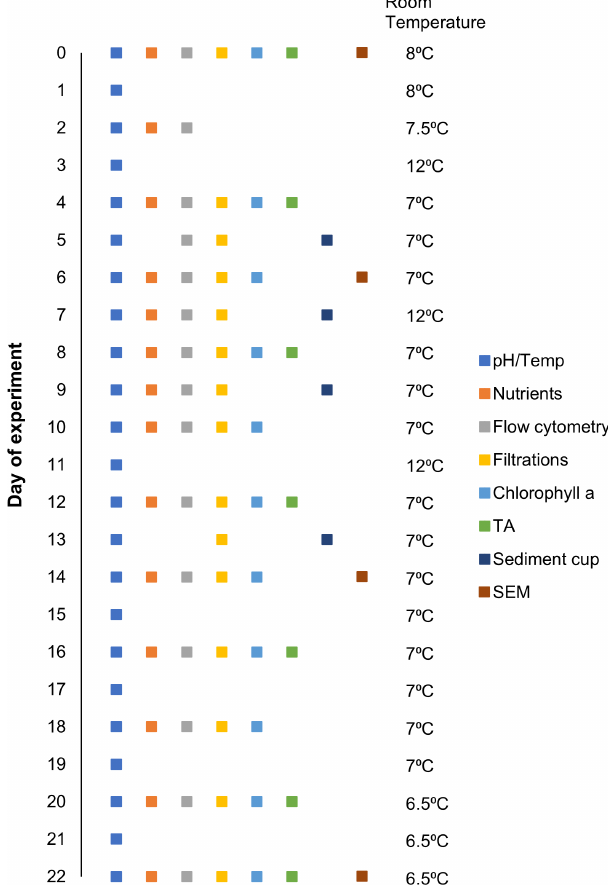
Figure 2. Sampling schedule for given parameters and room tem- perature on a given day (0–22) over the experimental